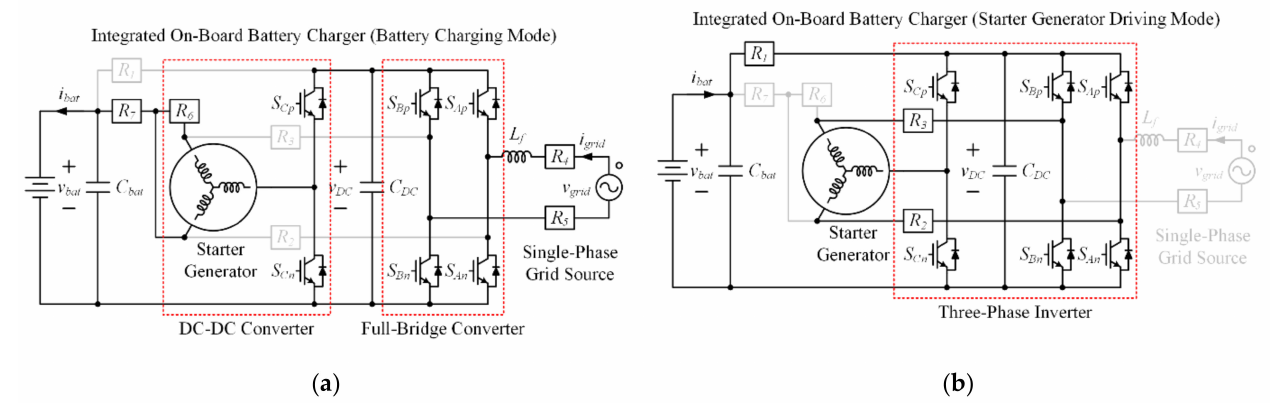
Figure 2. Circuit diagram of the integrated OBC depending on operation of power relays: ( a ) battery charging mode and ( b ) starter generator driving